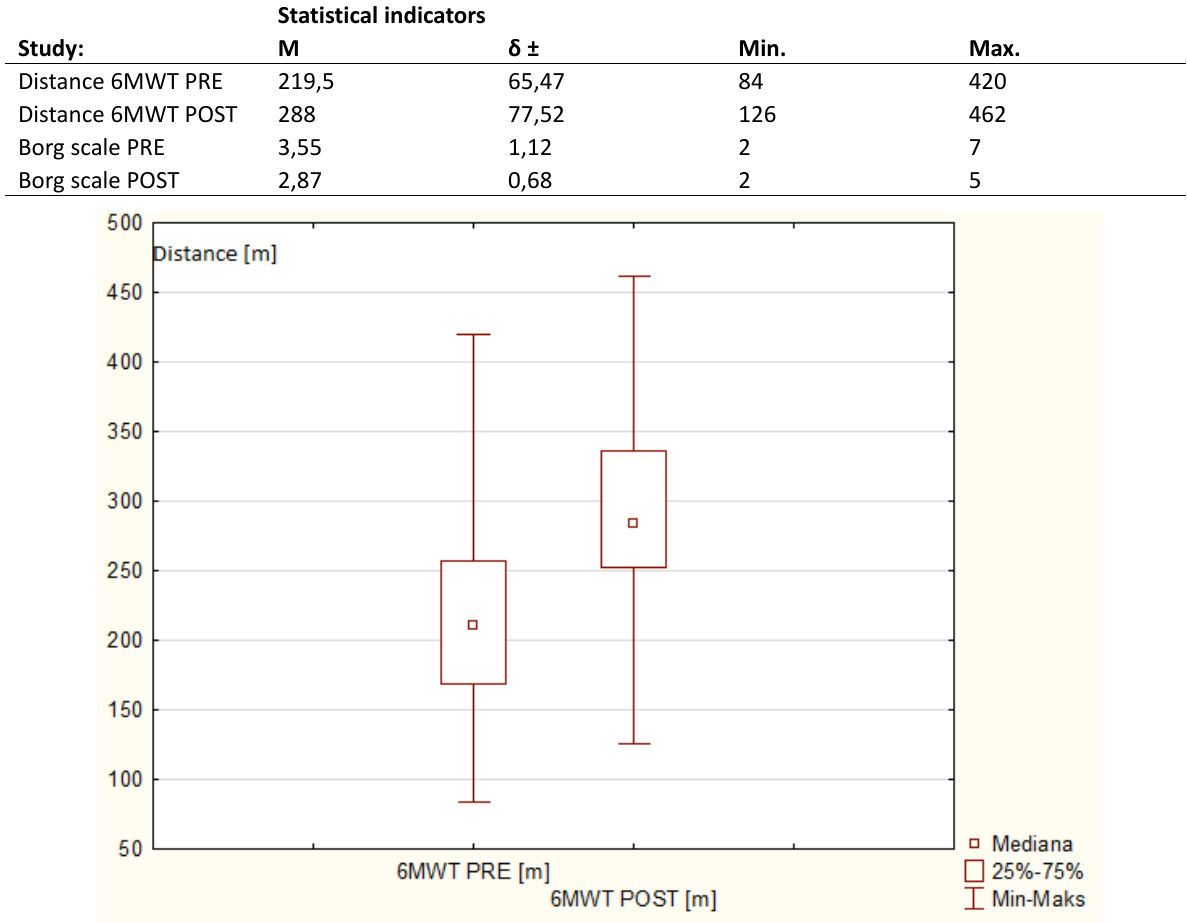
Table 1. 6MWT results before and after the rehabilitation cycle Statistical indicators